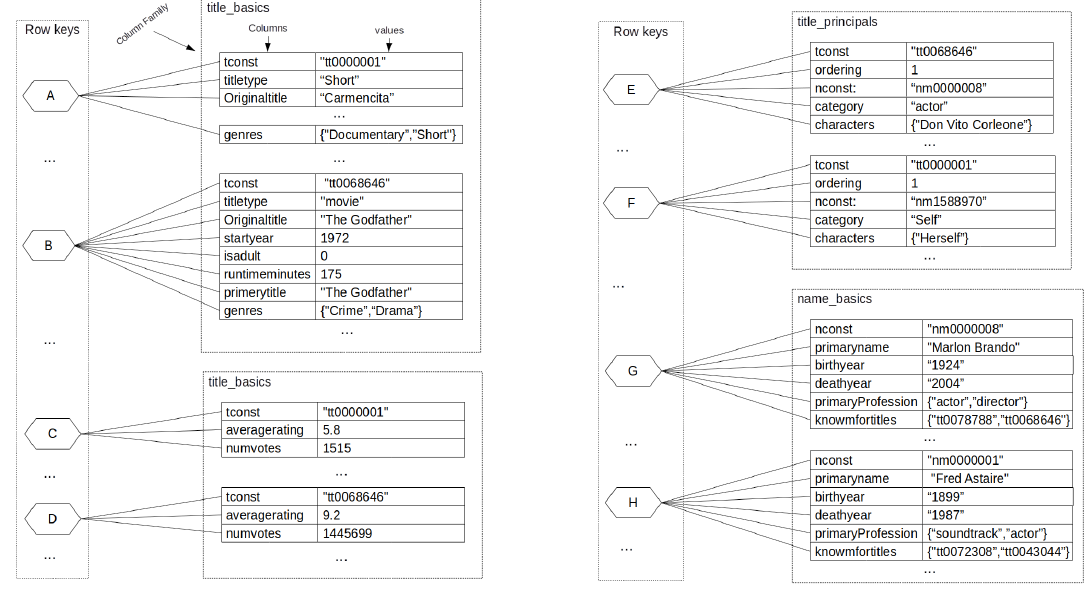
Figure 10. IMDb mapped to Cloudy according to the CloudyStore approach.